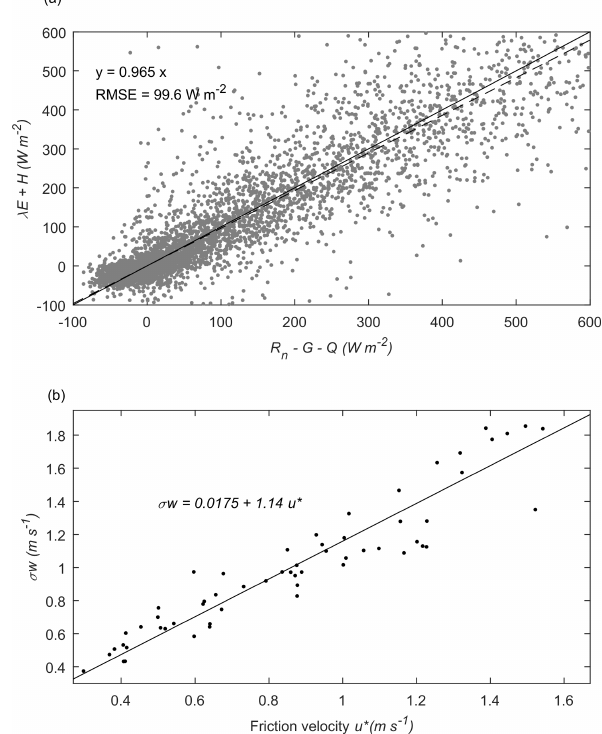
Figure 3. (a) Half-hour interval of turbulent heat fluxes ( H and λE ) vs. available energy ( R n − G − Q ) for the study site. The solid line represents the 1:1 line and the dashed line represents linear regres- sion forced through the origin. (b) Half-hour averages of standard deviation of the vertical wind speed σw (ms − 1 ) vs. friction veloc- ity u ∗ (ms − 1 ) , wet-canopy conditions P G > 0.5mm (30min) − 1 , and near-neutral stability ( − 0.02 <(z − d)/L< 0.02).